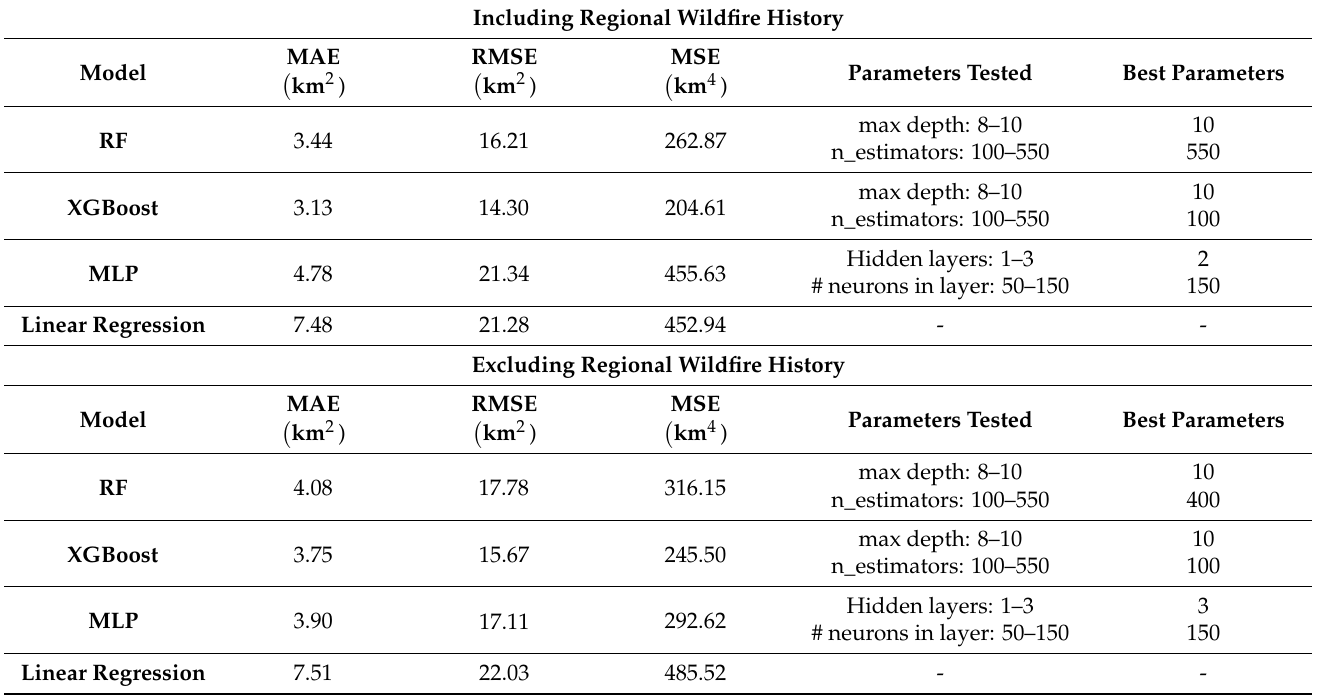
Table 4. Summary of model performances—size of burned